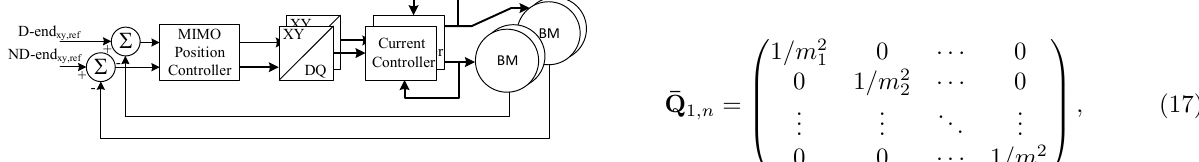
Figure 7: Block diagram of the position control